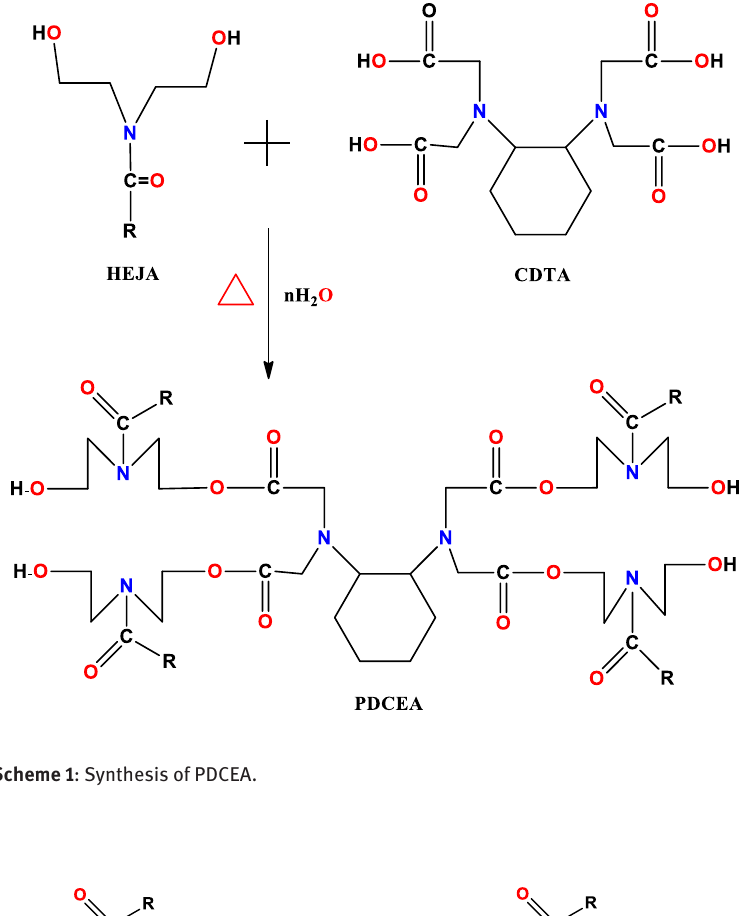
Scheme 1 .Synthesis of PDCEA